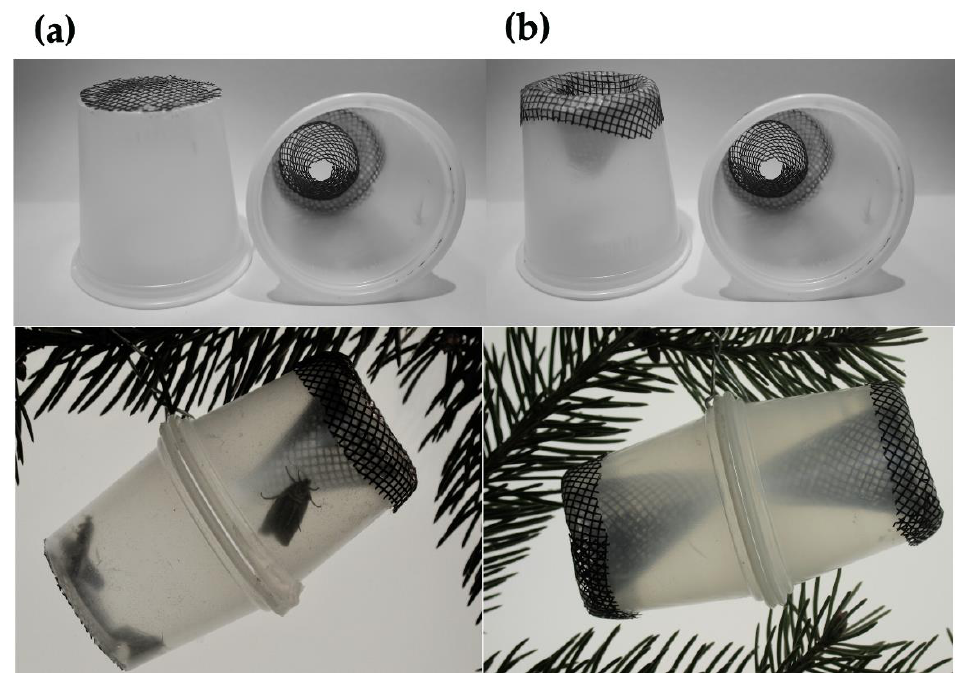
Figure 2. Cages used to assess mating success of female moths of spruce budworm. Top: Open cages; bottom: Closed cages. ( a ) Single-opening cage, used in 2008, containing one female and several trapped males. ( b ) Double-opening cage, used in 2013 and 2014. Cup diameter: 4 cm.